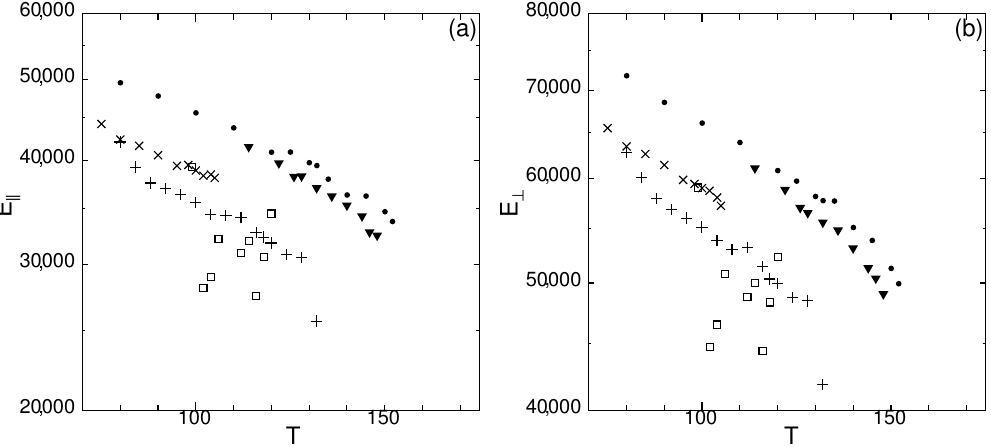
Figure 10. Temperature dependence of spontaneous elastic modulus of states G ( ▼ ), J ( ◻ ), M ( × ), O ( + ), and crystal ( ● ), in ( a ) longitudinal E ∥ and ( b ) transverse E ⊥ directions, for system size N =